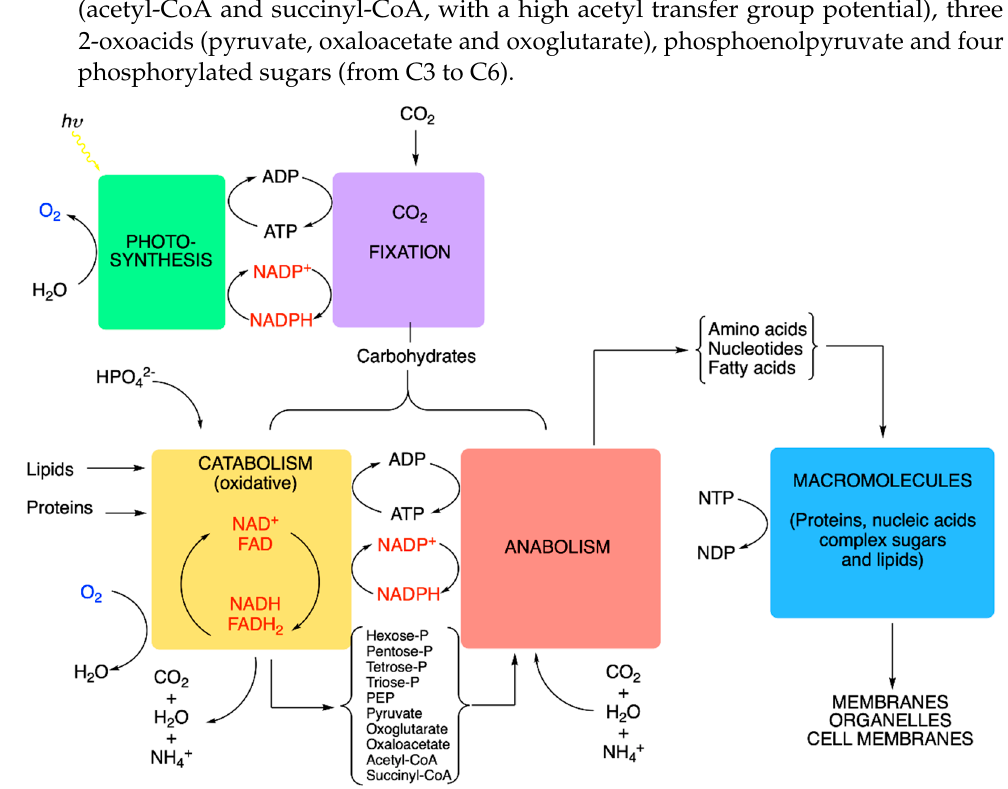
Figure 7. Metabolic compartmentation of redox couples (adapted and modified from [34]). Schematic representation of intermediary metabolism. In heterotrophic organisms, there are three metabolic blocks (catabolism, anabolism and macromolecule synthesis), to which two other blocks are added (photosynthesis, CO 2 fixation) in autotrophs. Notice the importance of five inorganic molecules: H 2 O, O 2 , CO 2 , NH 4+ and HPO 42 − ; the latter are the N and P donors. (PEP, phosphoenolpyruvate). NADH is produced by the catabolic pathways of glycolysis (cytoplasm), the ß-oxidation of fatty acids (mitochondria) and the TCA cycle (mitochondria), and its reducing equiva- lents are mainly used by the mitochondrial respiratory chain. The NAD + /NADH couple is thus essentially restricted to the catabolic block (Figure